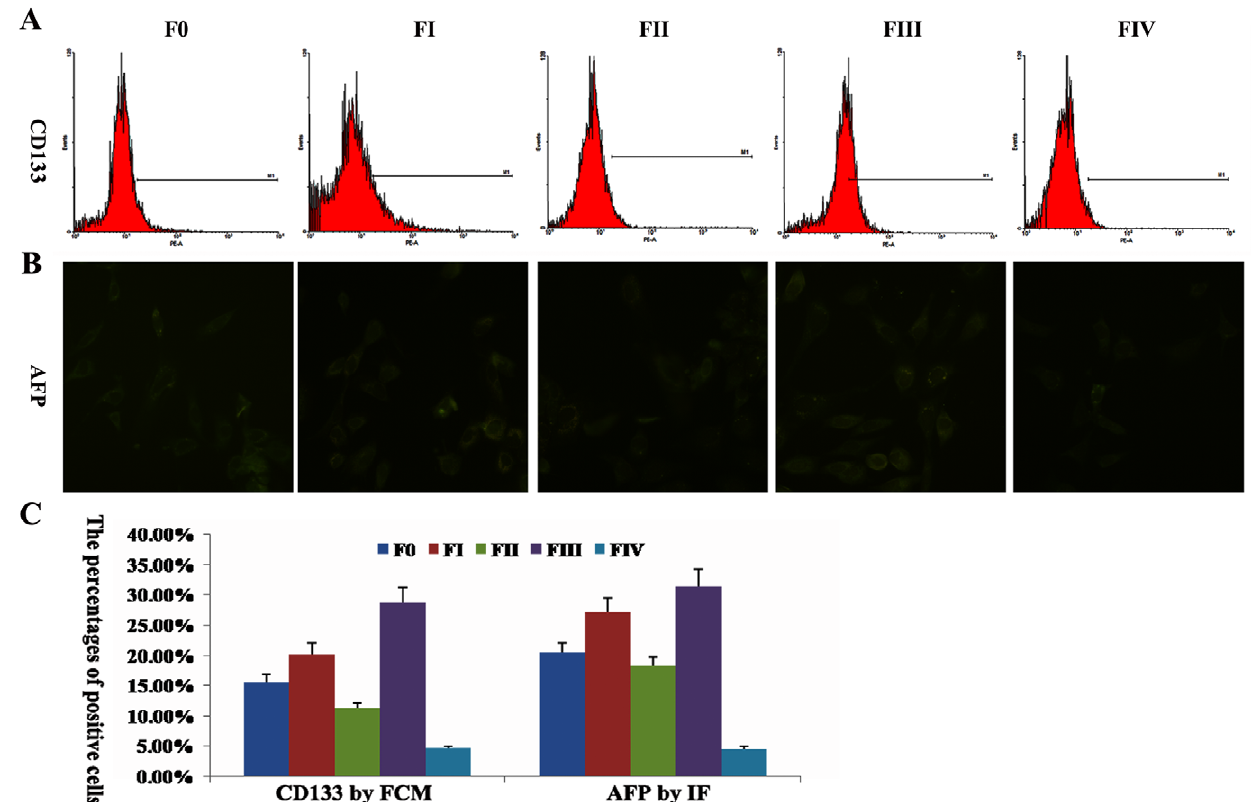
Figure 4. The differentiation of cells from each fraction induced by HGF. (A) Expression of stem cell marker CD133 in daughter cells from each fraction determined by FCM. (B) Based on IF, AFP-positive cells (green) were found in daughter cells from each fraction. (C) Column chart reflects the data of positive cells. F0 represents unfractionated HTCs; FI-IV indicates fractions I–IV after separation.